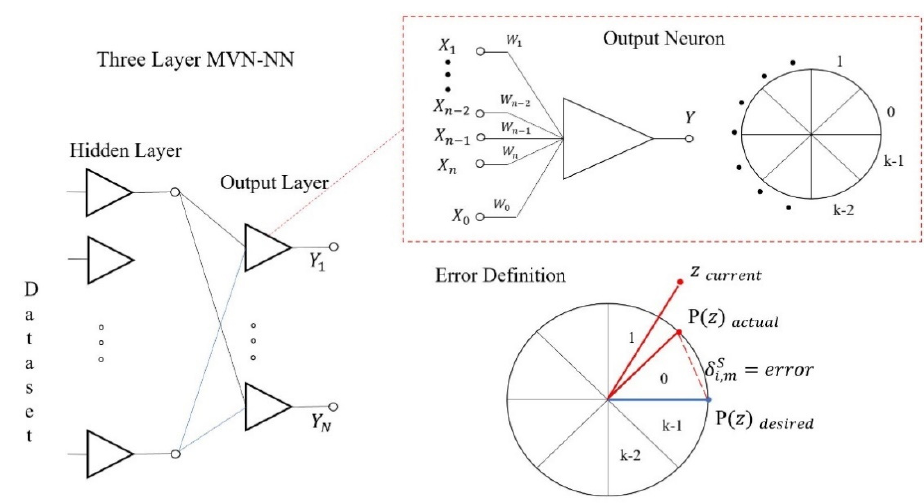
Figure 4. General configuration of the MLMVN and error definition in the output layer. Once the errors have been calculated for the output layer neurons, the errors should be backpropagated by applying Formula (12).